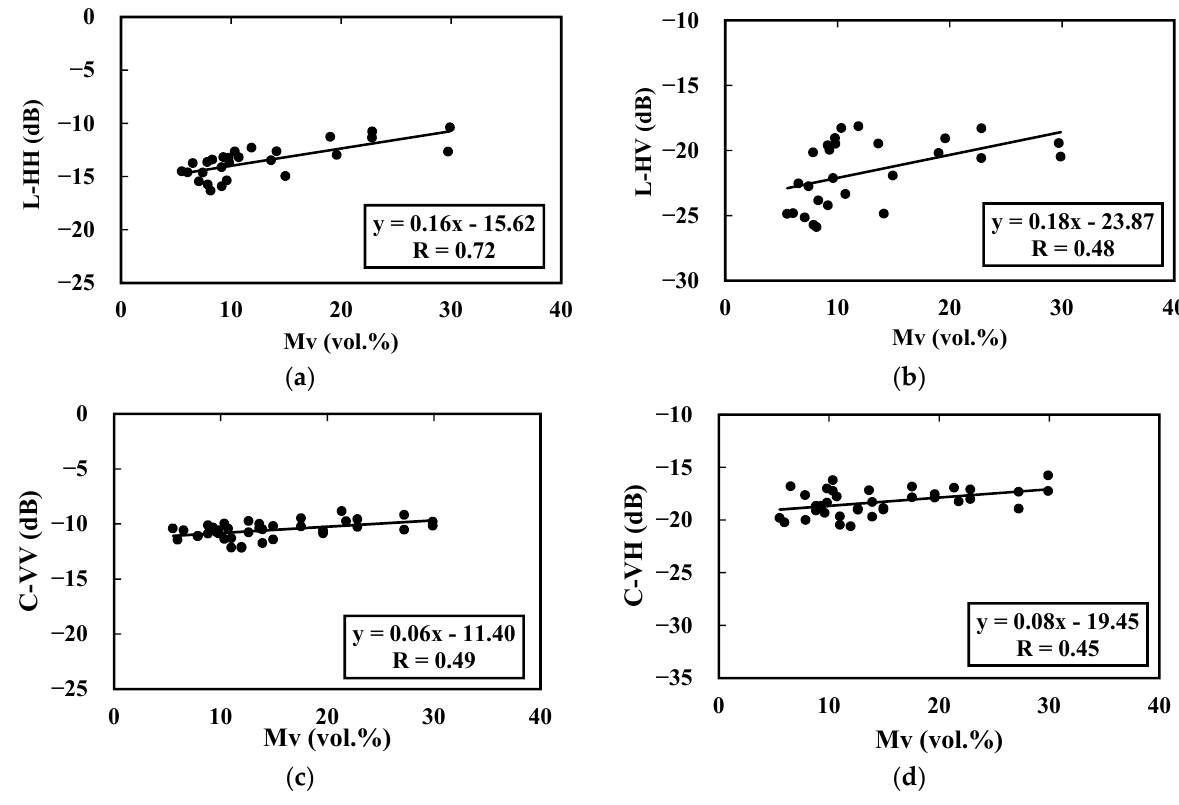
Figure 7. ALOS ‐ 2 and Sentinel ‐ 1 data as a function of soil moisture: L ‐ band in ( a ) HH and ( b ) HV Figure 7. ALOS-2 and Sentinel-1 data as a function of soil moisture: L-band in ( a ) HH and ( b ) HV polarizations and C ‐ band in dual ‐ polarizations ( c ) VV and ( d ) VH. polarizations and C-band in dual-polarizations ( c ) VV and ( d )